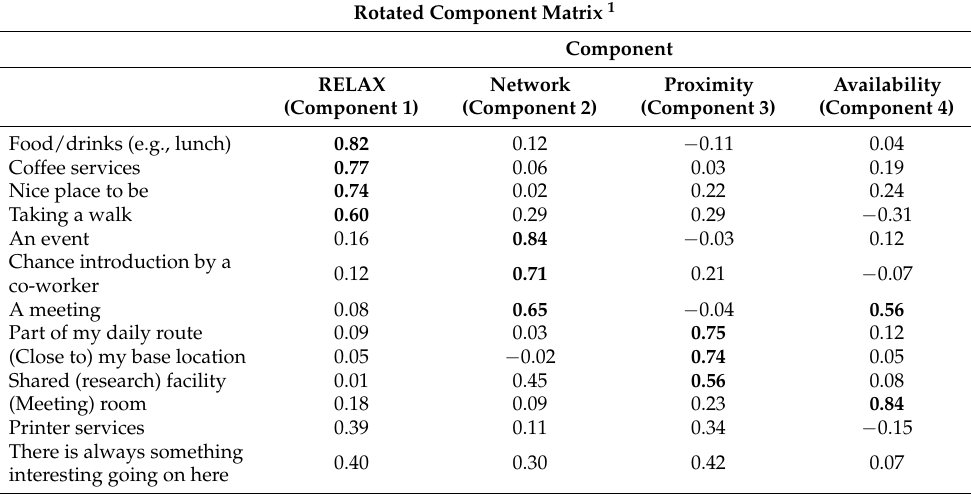
Table 8. Services, rotated component matrix with four components with their labels and factor load- ings on the variables. Factor loading >0.55 are in bold—”Please indicate what variables contributed to your interactions in your indicated